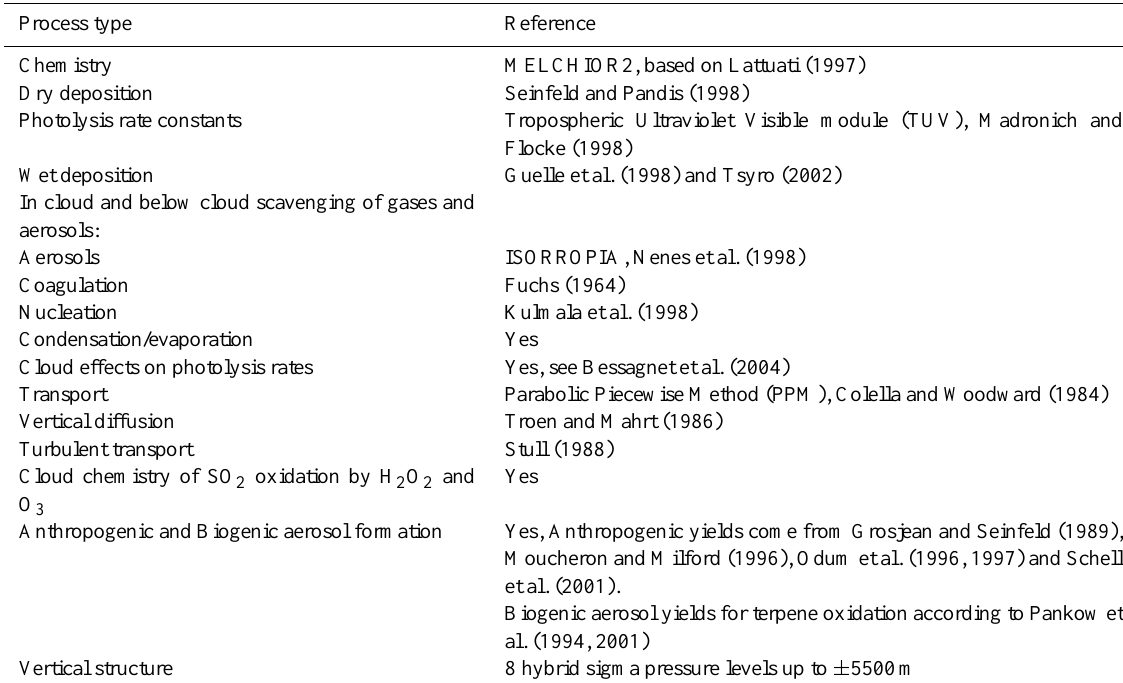
Table 1. Overview of the chemical and physical processes which are included in the air chemistry transport model CHIMERE. For a more detailed description of the processes in CHIMERE, see Bessagnet et al. (2004).